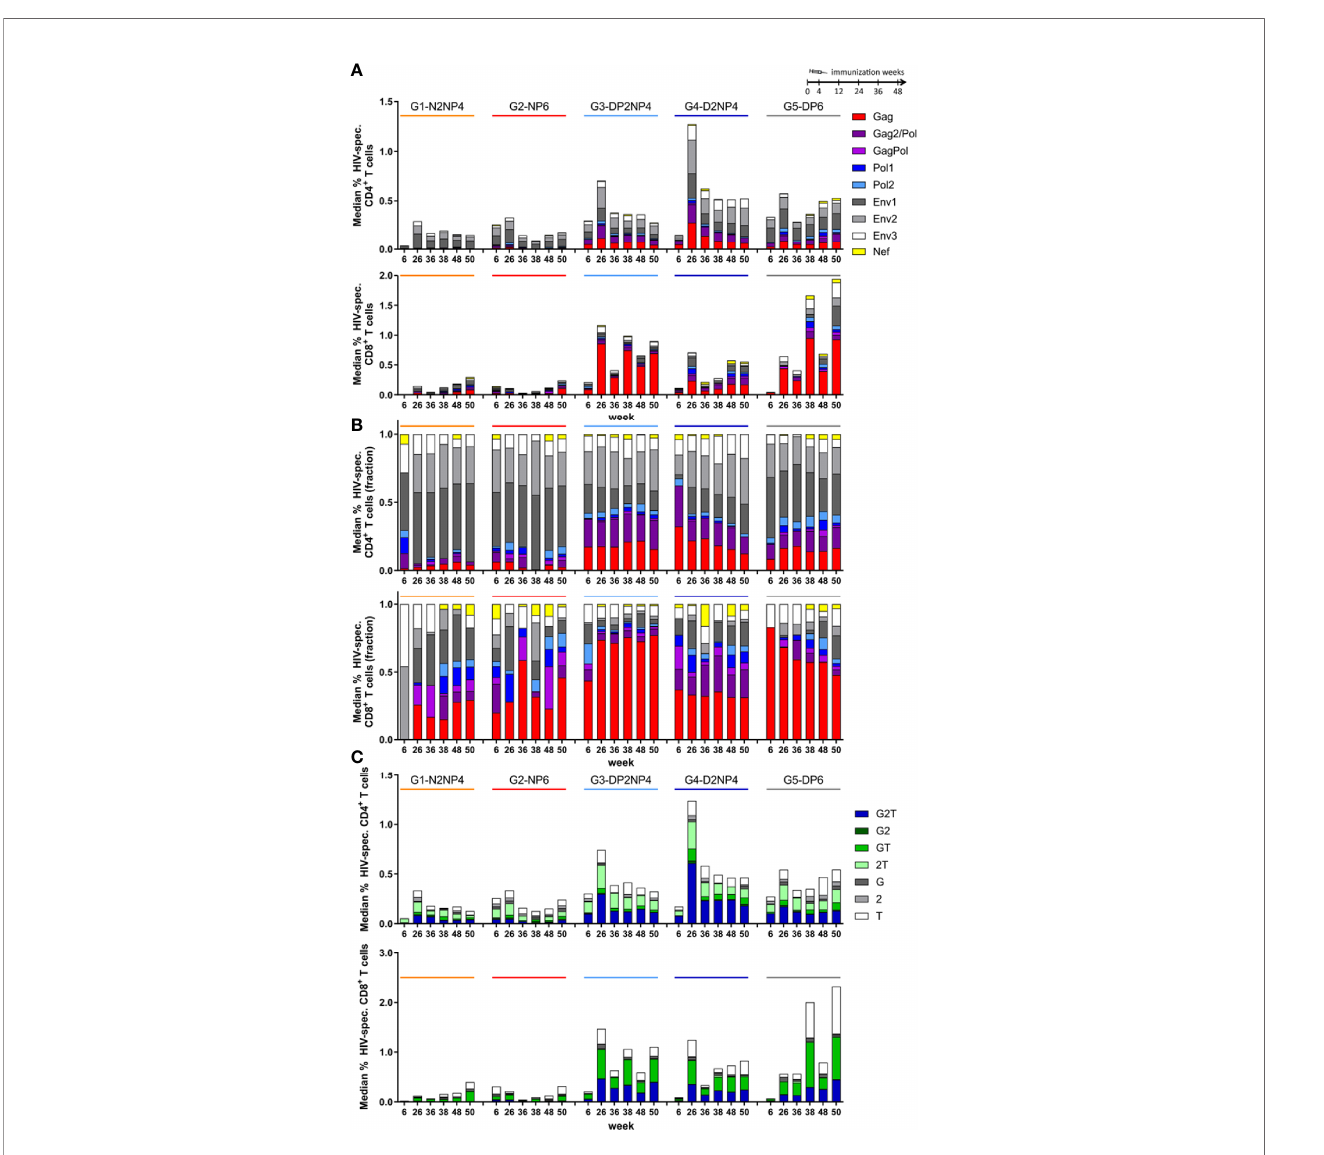
FIGURE 4 | HIV-1-speci fi c CD4 + and CD8 + T cell responses by ICS assay broken down according to peptide pool reactivity and cytokine pro fi le. Absolute (A) or normalized (B) data from Figure 3 shown as median responses towards the 9 peptide pools used (sum of all cytokines). (C) Absolute data from Figure 3 shown as median responses of cells producing IFN- g ( “ G ” ), IL-2 ( “ 2 ” ) or TNF ( “ T ” ) alone or in all combinations (sum of all peptide